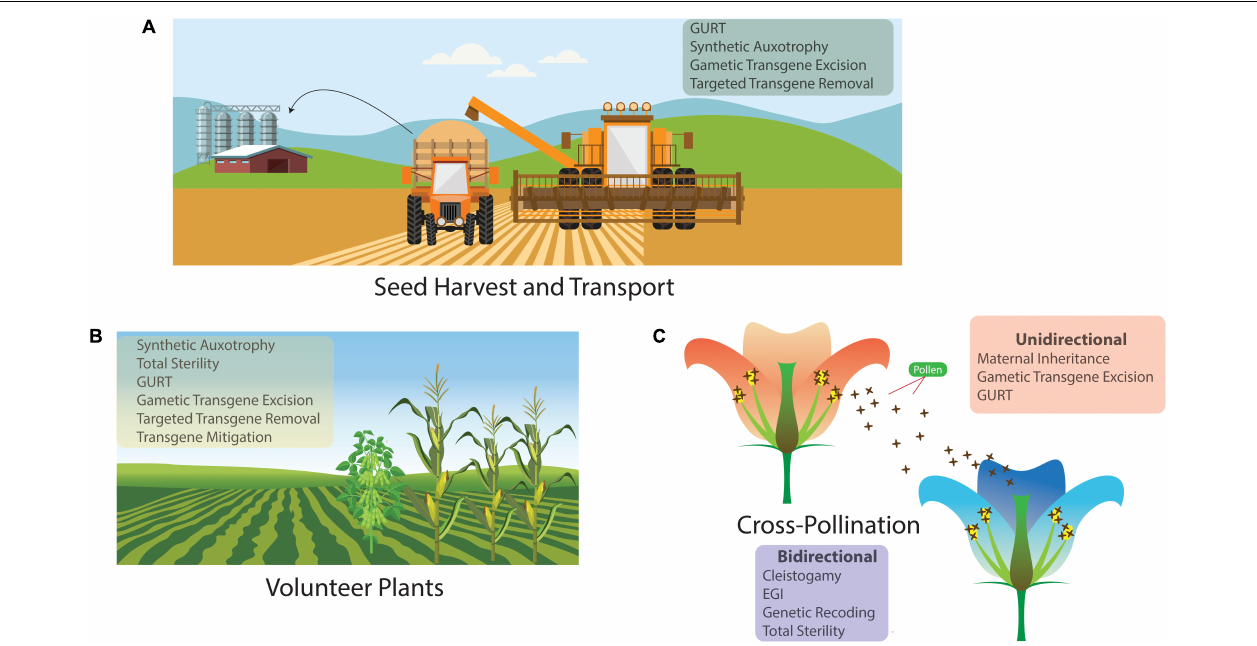
FIGURE 1 | The three main pathways for unwanted contamination or gene flow in an agricultural setting; with a list of the genetic biocontainment technologies that could be used to reduce the possibility of the gene flow occurring. (A) Seed dispersal during harvest and transport. (B) Contamination from volunteer plants. (C) Genetic biocontainment can limit pollen-mediated gene flow unidirectionally, where transgenes are prevented from spreading from the transgenic crop into neighboring plants, and it can operate bidirectionally, where gene flow into the transgenic crop is also limited.